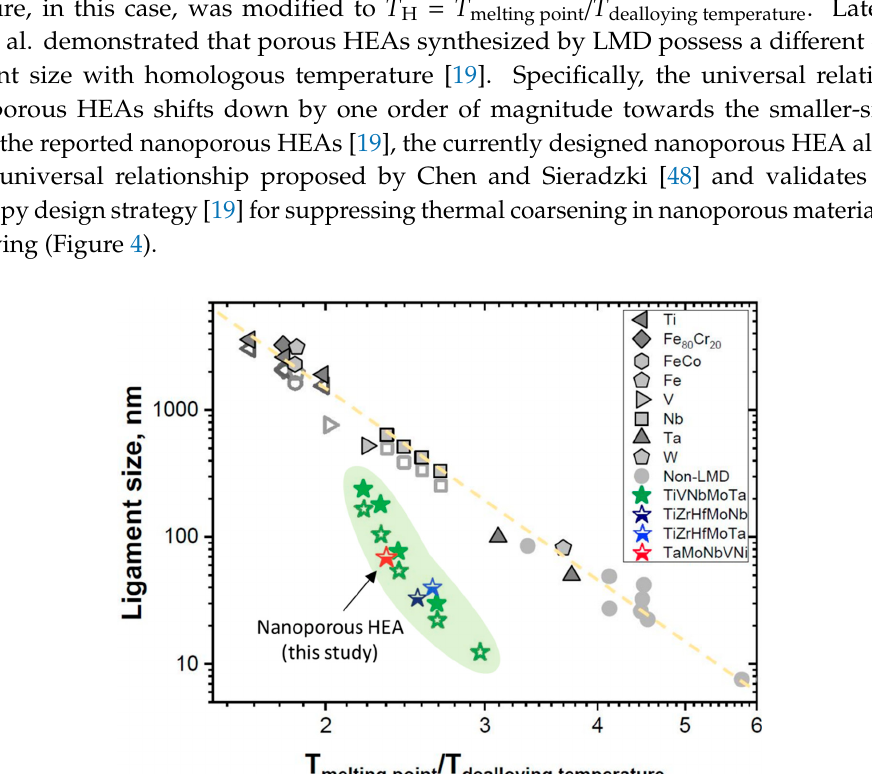
materials: 10 min—open symbols, 20 min—half-open symbols, and 60 min—closed